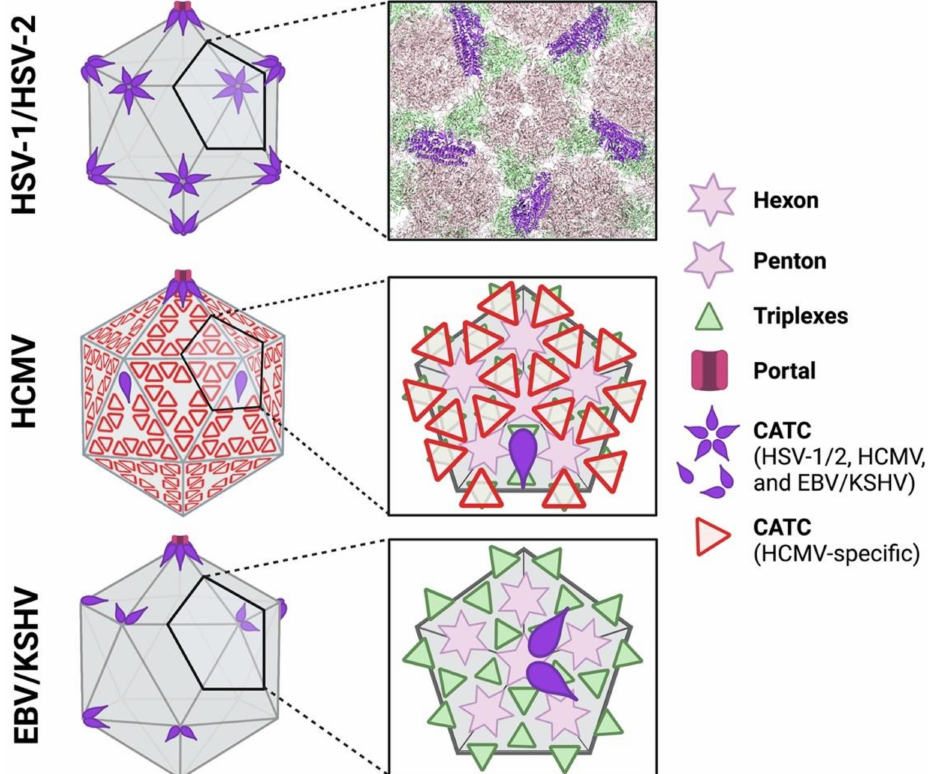
Figure 3. Comparison of the CATC location and occupancy on the capsid among the representatives of the three human herpesvirus subfamilies. In both alpha (HSV-1/2) and gammaherpesviruses (EBV/KSHV), the CATC (purple raindrops) is composed of three proteins (HSV1/2: UL17, UL25, and UL36; EBV: CVC1, CVC2, and LTP; KSHV: ORF32, ORF19, and ORF64) and is located at capsid pentonal vertices. CATC on HSV1/2 capsids is present at a full occupancy whereas CATC on gammaherpesvirus capsids is present at a lower occupancy. Unusually, HCMV has two types of CATCs. The first CATC type (purple raindrops) is the conserved complex of UL93, UL77, and UL48 (homologs of UL17, UL25, and UL36) present at the lowest occupancy and positioned slightly below pentons. The other CATC type (red triangles) is betaherpesvirus-specific and covers the entire capsid like a net. In all three subfamilies, the portals are fully occupied by the CATC. Insets show CATC location relative to the MCP hexons, MCP pentons, and triplexes. For clarity, the SCP is not shown. The HSV-1/2 inset shows the 3D structure of this region of the HSV-1 capsid (UL25 globular domains not shown; PDB: 6CGR), generated using Chimera [79]. This figure was created with BioRender.com, accessed on 17 September